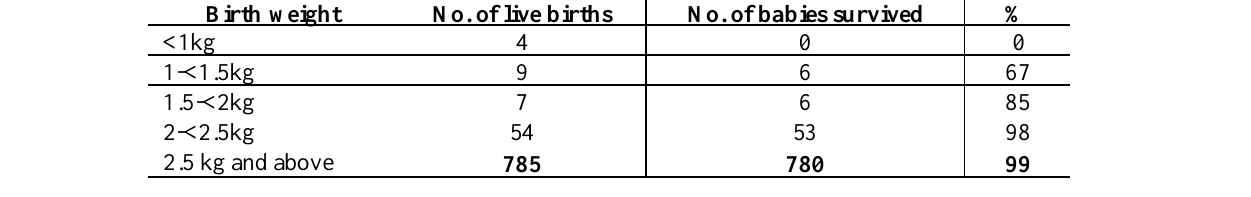
Table V : Survival of babies born at KMCTH by birth weight Birth weight No. of live births